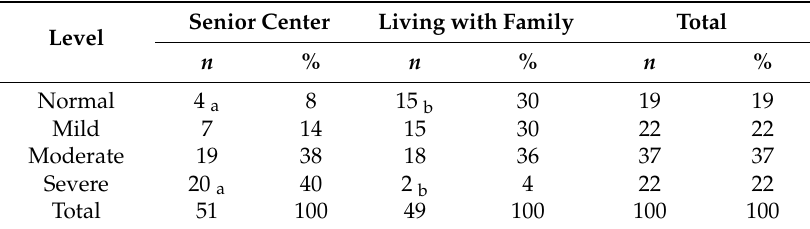
Table 2. Hopelessness levels of the participants with respect to